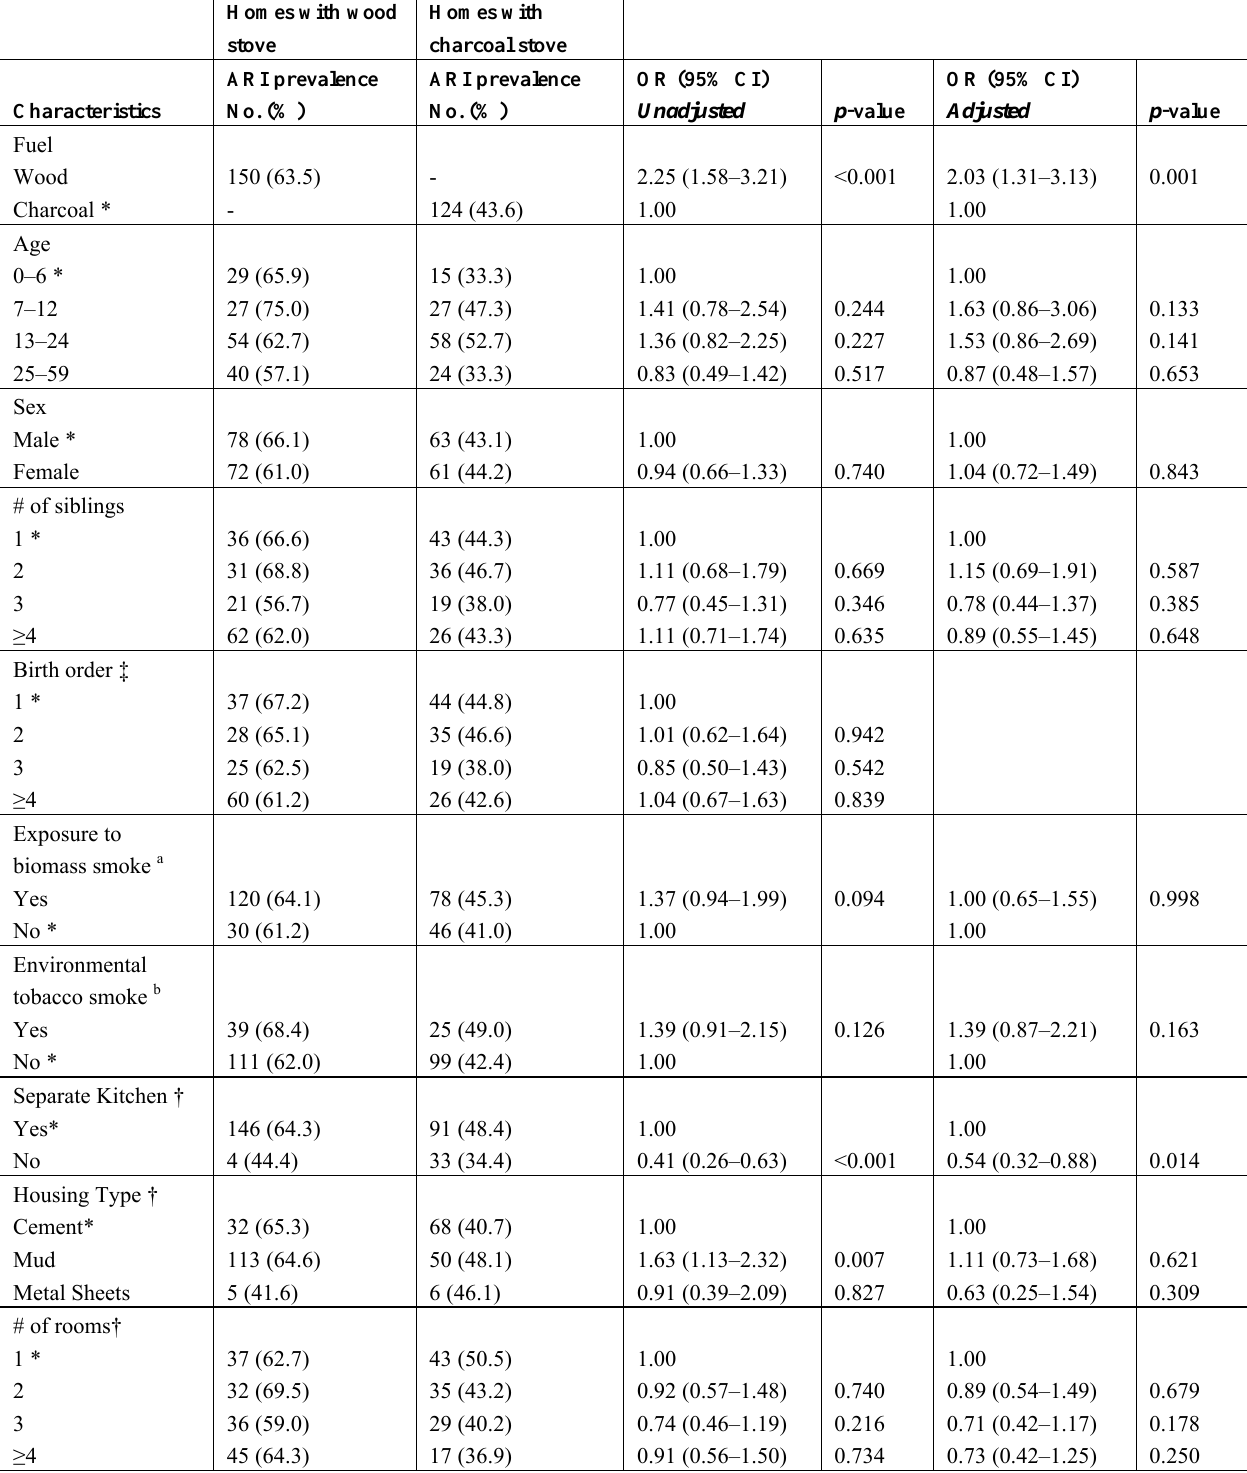
Table 4. ARI prevalence in children (under 5 years) and odds ratio estimate of the effect of cooking fuel types (wood and charcoal) and other variables during the two weeks preceding the